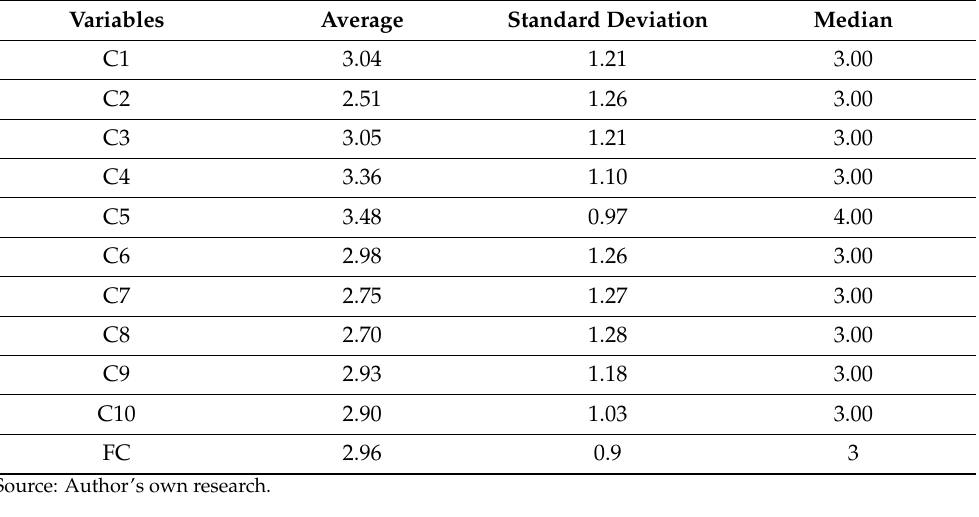
Table 2. Functioning of the creative sector in Polish cities.